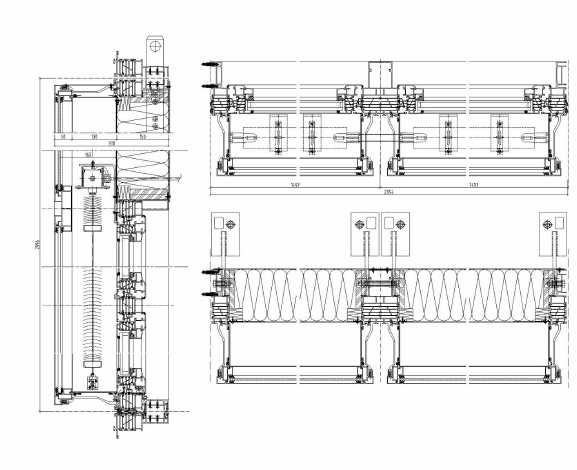
Figure 15: Characteristic sections of the double skin facade element.